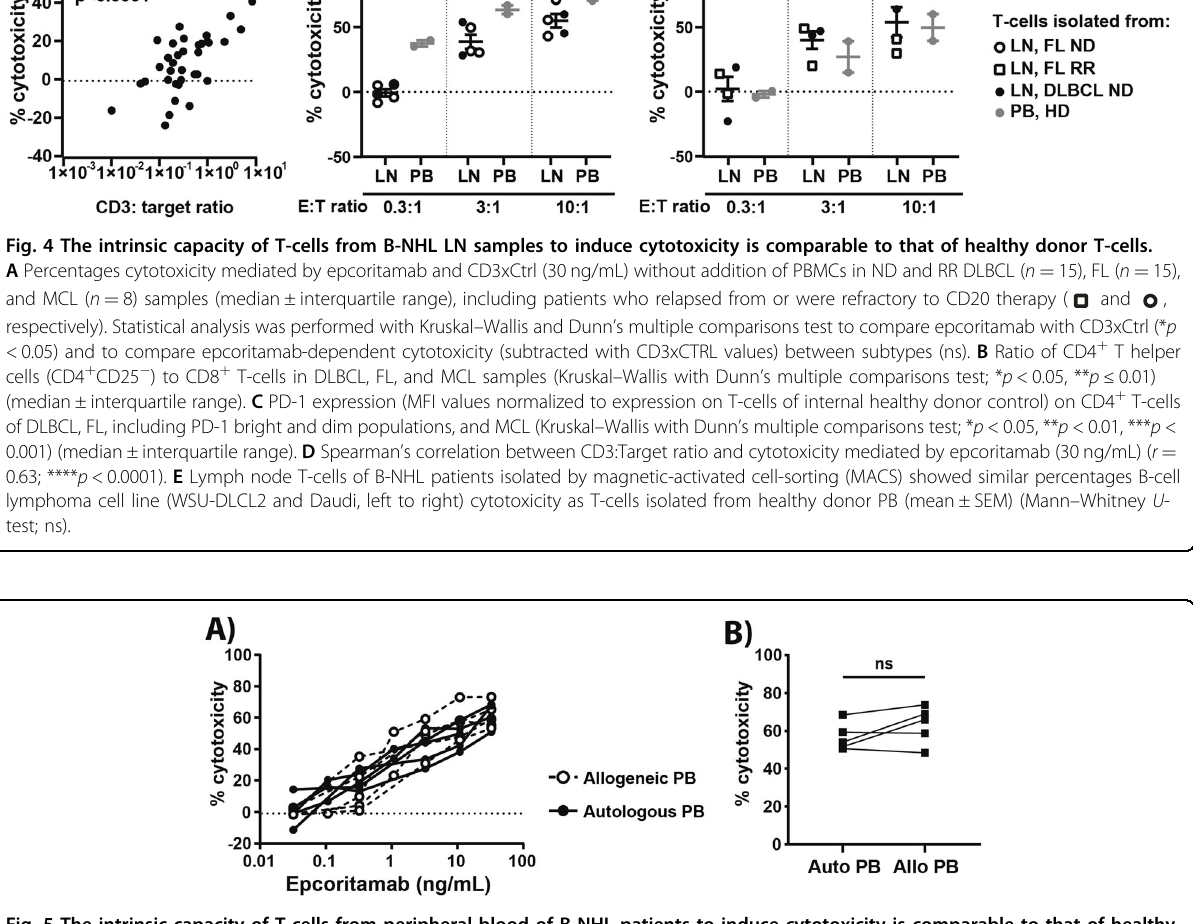
Fig. 5 The intrinsic capacity of T-cells from peripheral blood of B-NHL patients to induce cytotoxicity is comparable to that of healthy donor T-cells. A Dose-response of and B maximal cytotoxicity induced by epcoritamab in B-NHL cells in the presence of allogeneic healthy donor PBMCs or autologous B-NHL patient PBMCs in a 10:1 E:T ratio ( n = 5; Wilcoxon matched-pairs signed rank test; ns).